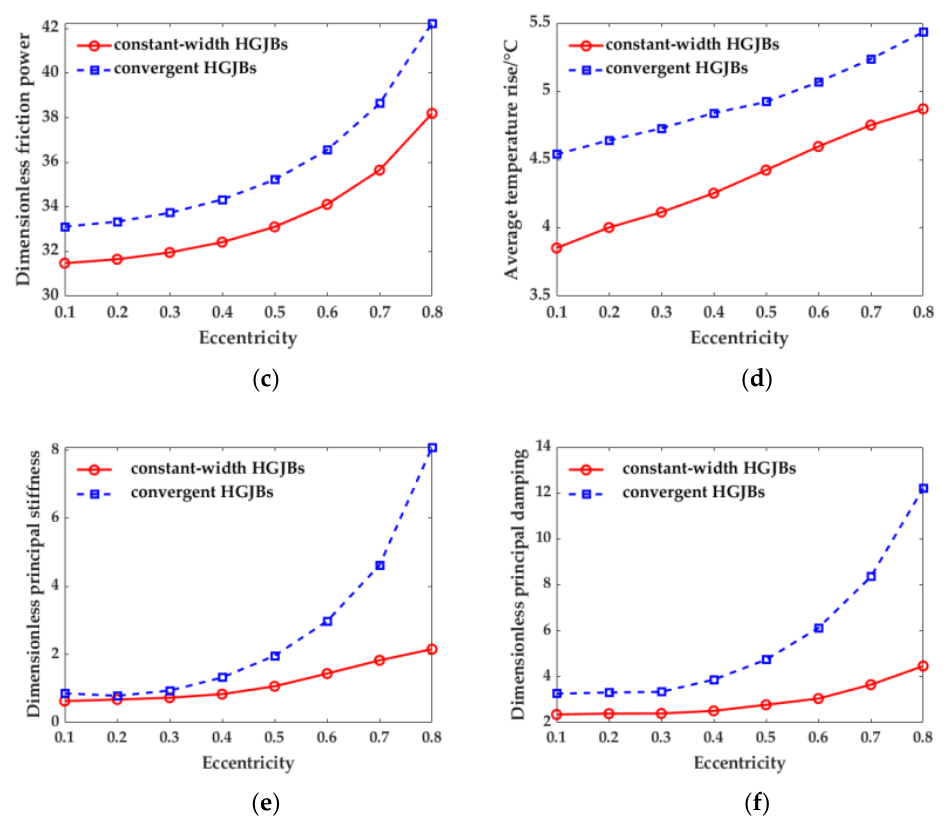
Figure 14. Comparison of two bearing static performance and dynamic performance: ( a ) Dimensionless load capacity ( b ) Side leakage ( c ) Dimensionless friction power ( d ) Average temperature rise ( e ) Dimensionless principal stiffness ( f ) Dimensionless principal damping.